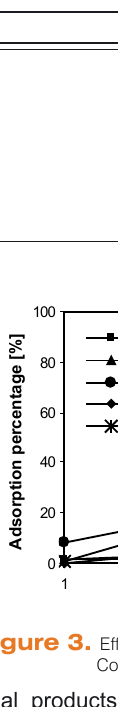
Table 1. Elemental analysis data.